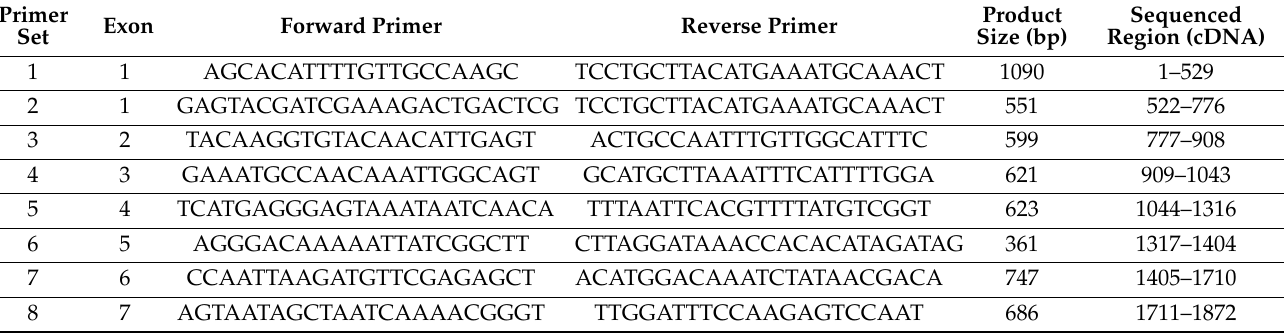
Table 6. Primer sets used in this